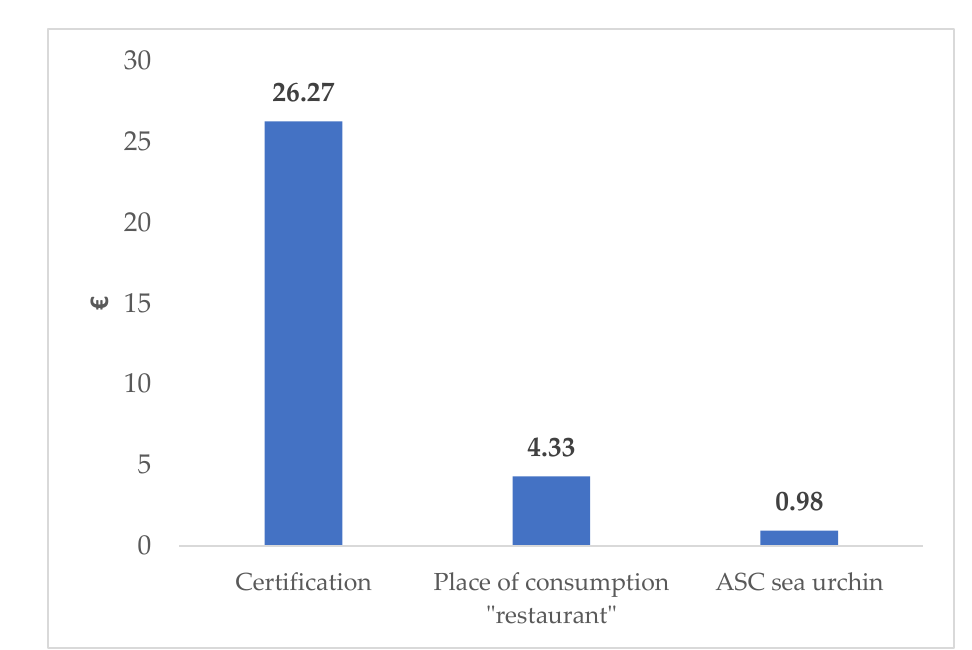
Figure 4. Apulian consumers’ willingness to pay for the consumption of sea urchin. ASC refers to alternative specific constant, which here represents the “ none ” option in each choice set.